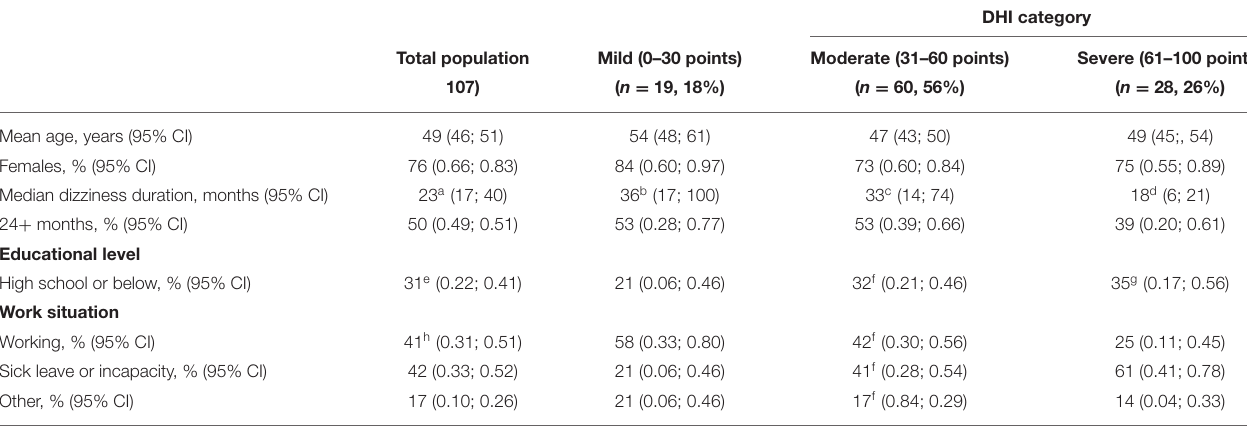
TABLE 1 | Demographic data among participants with persistent dizziness, presented for the total population and categorized into three levels of severity of the Dizziness Handicap Inventory (DHI).